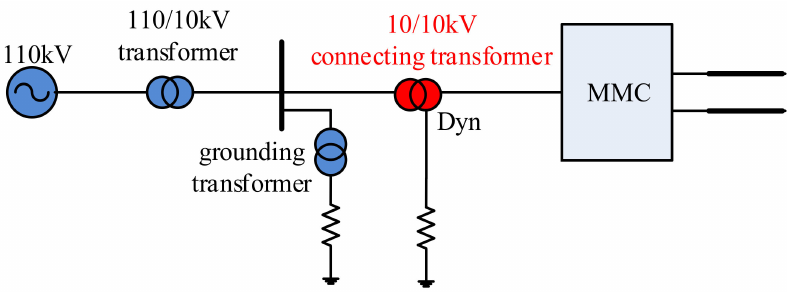
Figure 5. Diagram of the DC distribution system with connection transformers.